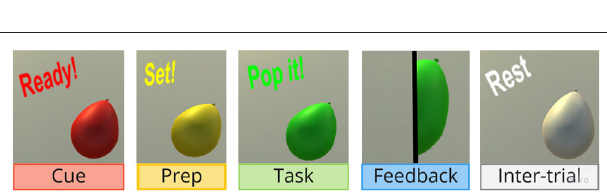
FIGURE 1 | The different embodiment conditions in the design. In the avatar hand condition a hand held the balloon while two semi-transparent blocks surrounded the balloon in the blocks condition.